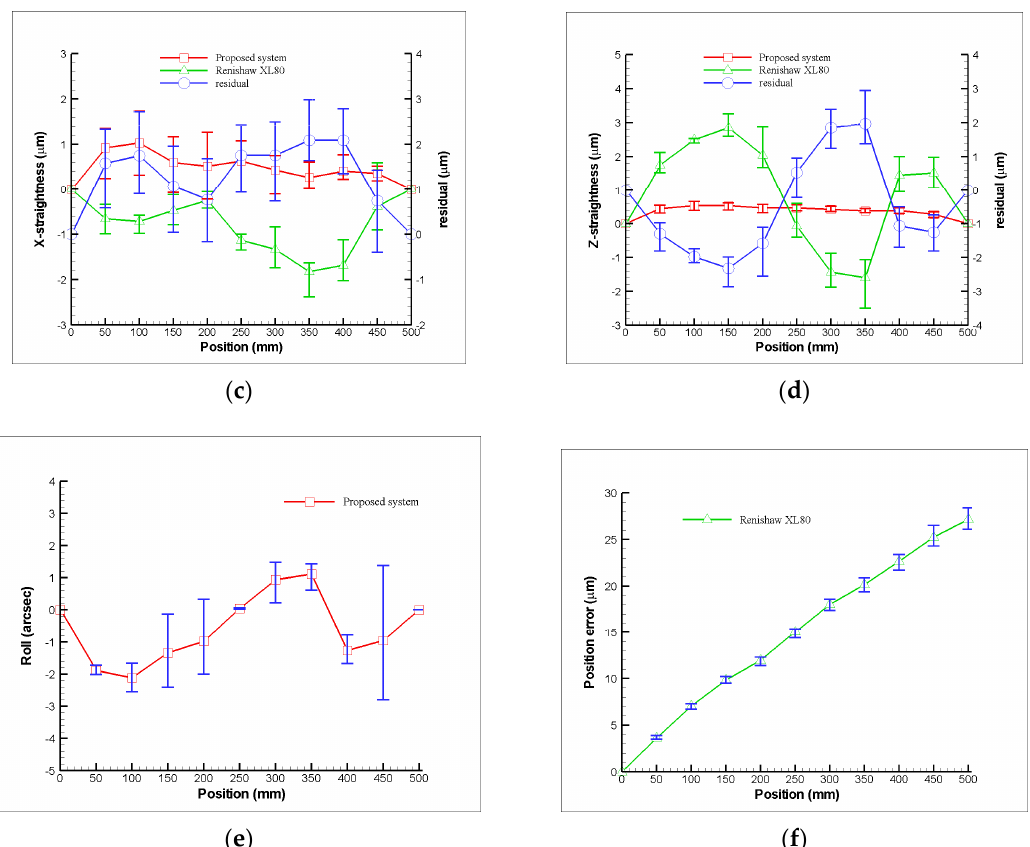
Figure 12. Measurement results for variation of geometric error with position: ( a ) pitch, ( b ) yaw, ( c ) horizontal straightness, ( d ) vertical straightness, ( e ) roll, and ( f ) positioning errors, respectively.